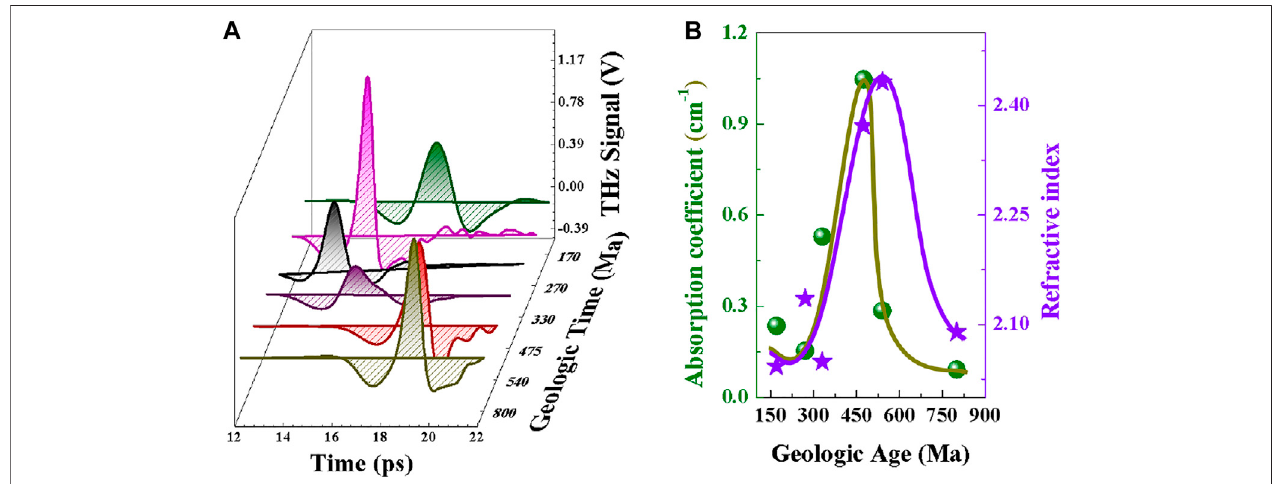
FIGURE 4 | (A) THz-TDS results for the six sedimentary rocks with different geological ages; and (B) Absorption coef fi cients and refractive indexes of the six sedimentary rocks with different geological ages.